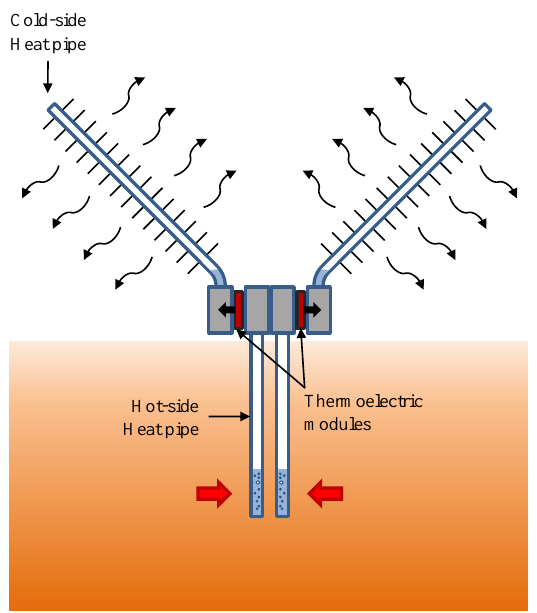
Figure 1. Schematics of a geothermal thermoelectric generator (GTEG) with heat pipes as heat exchangers.